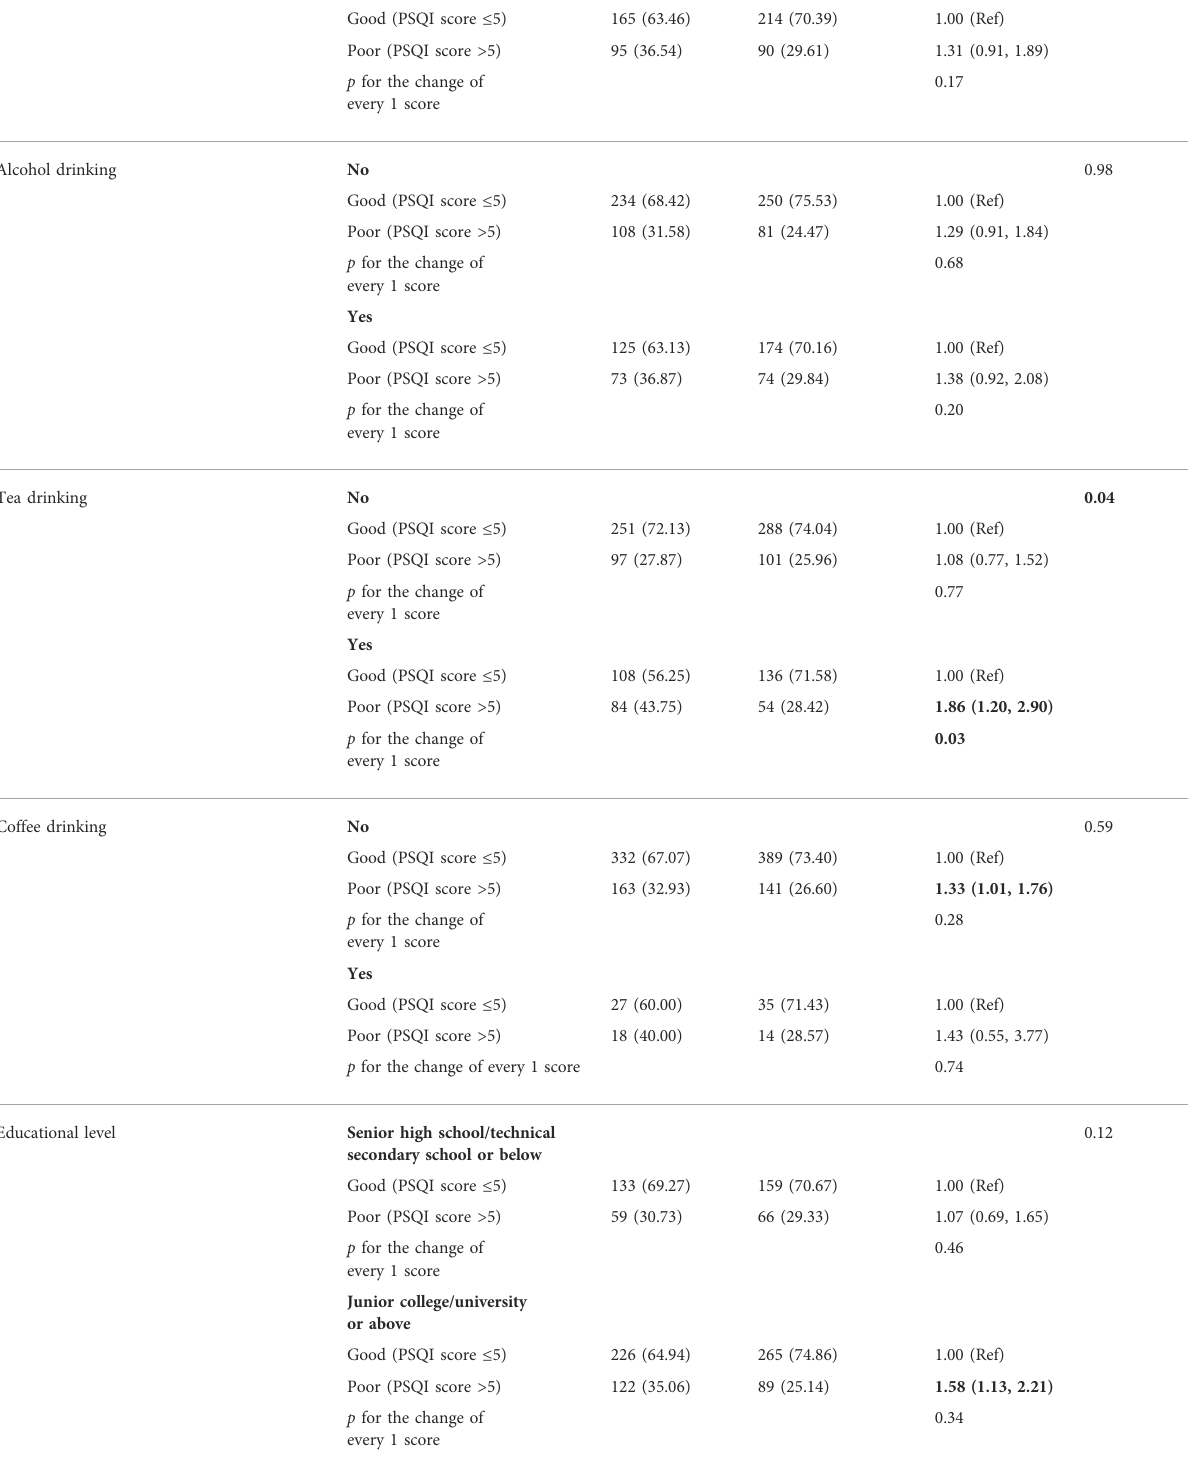
TABLE 3 ( Continued ) Subgroup analyses of the associations between sleep quality and asthenozoospermia